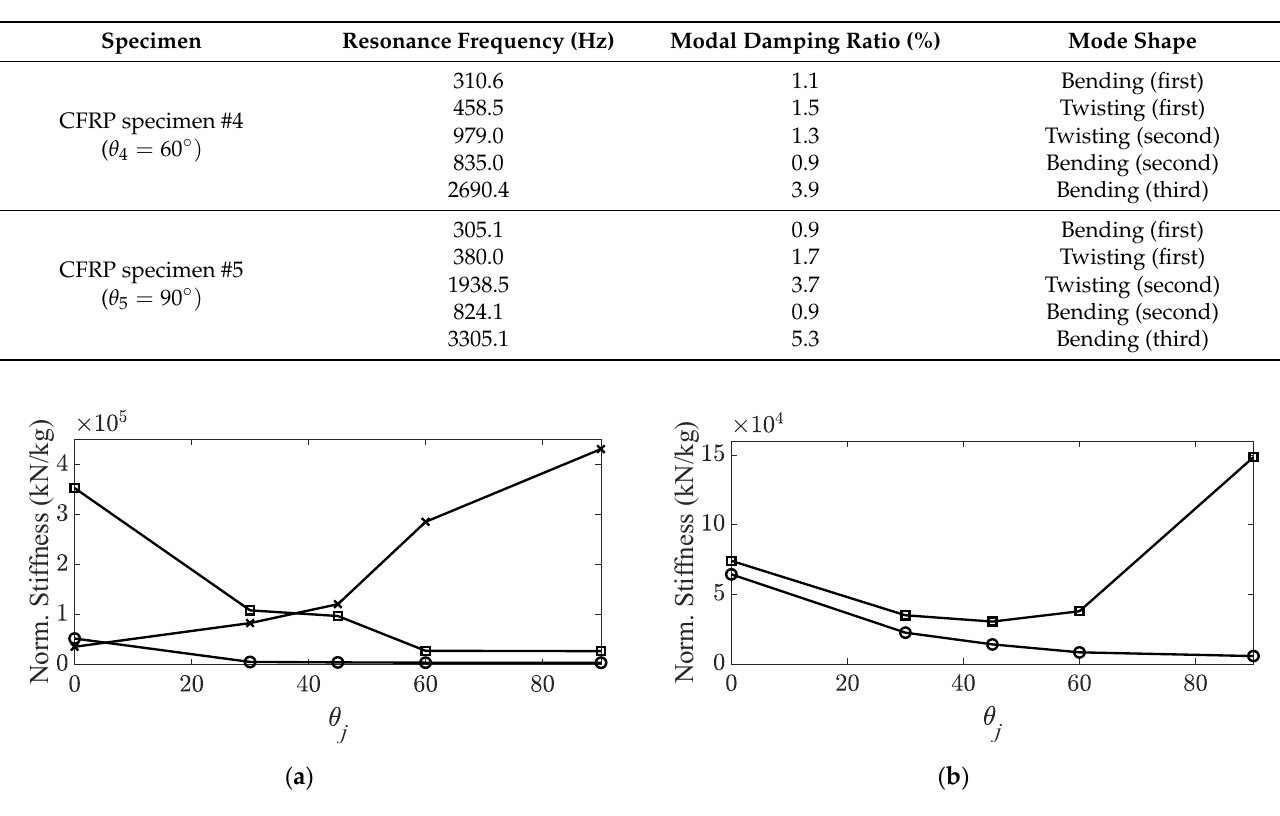
Figure 4. Variations in structural stiffness according to carbon fiber angle: ( a )